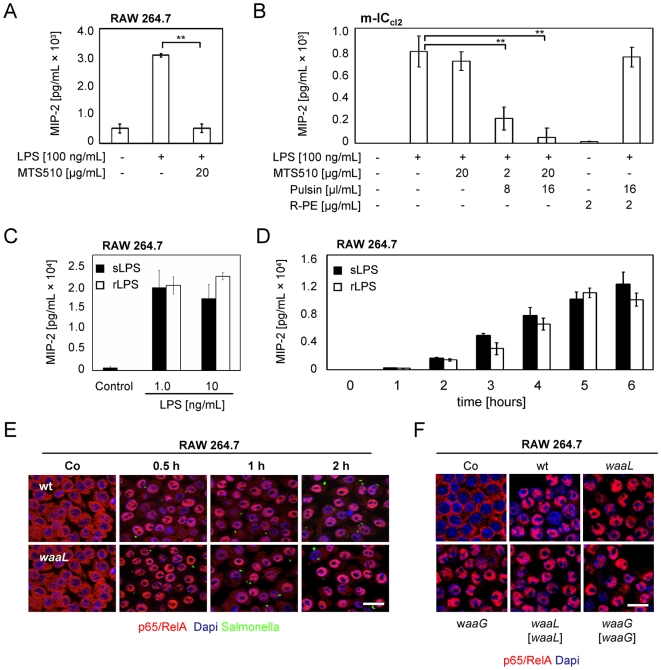
Delayed recognition is not observed in macrophages carrying TLR4 on the plasma membrane.(A) Anti-TLR4/MD2 antibody treatment abolishes LPS-mediated stimulation of RAW 264.7 macrophages. (B) In contrast, anti-TLR4/MD2 antibody-mediated inhibition of LPS-induced m-ICcl2 cell activation requires the presence of the protein delivery reagent PULSin. (C and D) RAW 264.7 macrophages were exposed to smooth LPS (sLPS), or rough LPS (rLPS), at the indicated concentrations for 2 hours (C), or at 10 ng/mL for the indicated time points (D), and the amount of secreted MIP-2 was quantified. (E and F) RAW 264.7 macrophages were coincubated with wildtype S. Typhimurium or an isogenic O-antigen deficient waaL mutant carrying a constitutive GFP plasmid for the indicated time points, and nuclear translocation of the NF-κB subunit p65/RelA was visualized by immunostaining. (F) RAW 264.7 macrophages were coincubated with wildtype S. Typhimurium, O-antigen deficient ΔwaaL or ΔwaaG mutants, or their respective complemented strains for one hour and nuclear translocation of the NF-κB subunit p65/RelA was visualized by immunostaining. Bar, 10 µm. **, p<0.01.